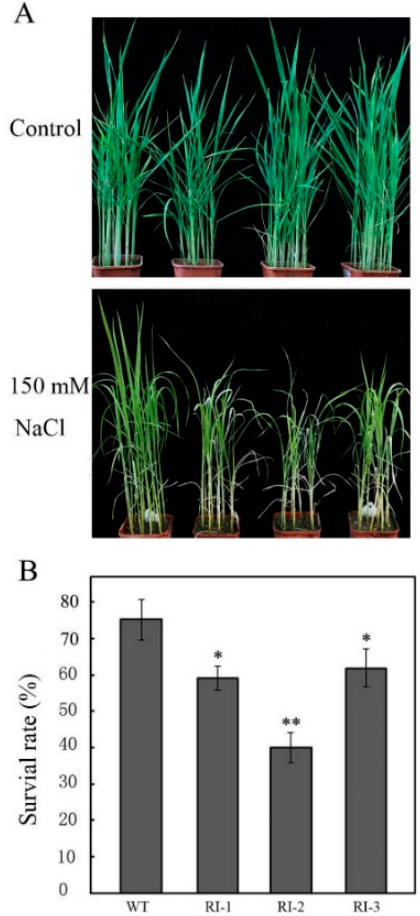
Figure 2. Inhibiting the expression of OsVTC1-3 decreased the tolerance of rice to salt stress. ( A ) The phenotype of OsVTC1-3 RNA interfering (RI) lines under salt stress. Control indicates that rice seedlings were grown under normal conditions, and NaCl indicates that seedlings were treated with 150 mM NaCl. ( B ) The survival rate percentage of OsVTC1-3 RI lines after salt treatment in the experiment in ( A ). WT represents ZH17 rice variety; RI-1 and RI-2 indicate different independent RNA interference lines of OsVTC1-3 in the ZH17 background, respectively. About 50–60 seedlings were used in each experiment. The bars represent SE (±) of three independent assays, and the asterisk indicates results significantly different from that of WT (** p < 0.01 and * p < 0.05). Significance was evaluated by using the t -test.